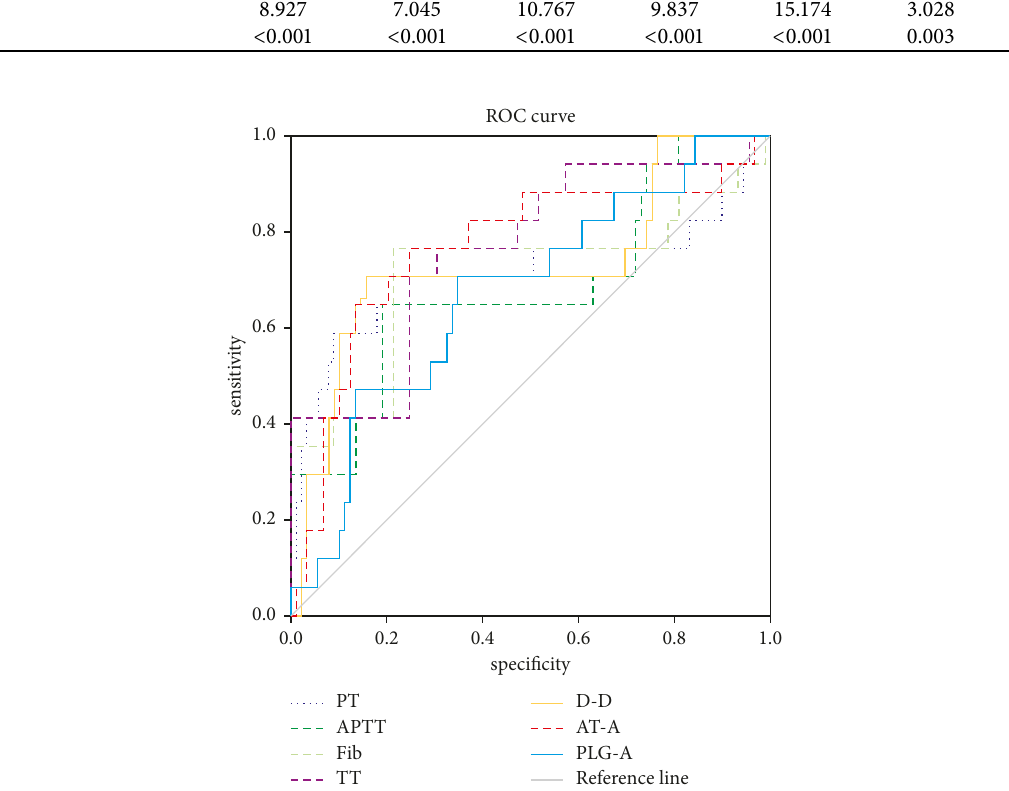
Figure 3: Predictive effect of coagulation and fibrinolysis indexes on patient outcomes.